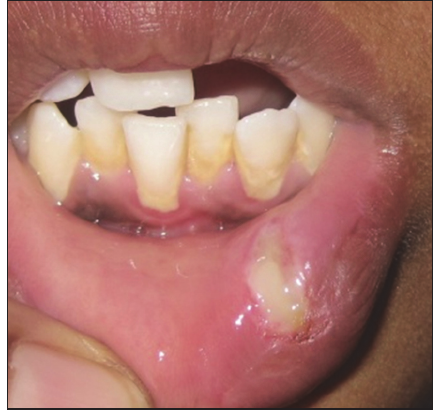
Figure 6: Photomicrograph showing H&E 40x view zone of coagulation necrosis surrounding the intended biopsy material.